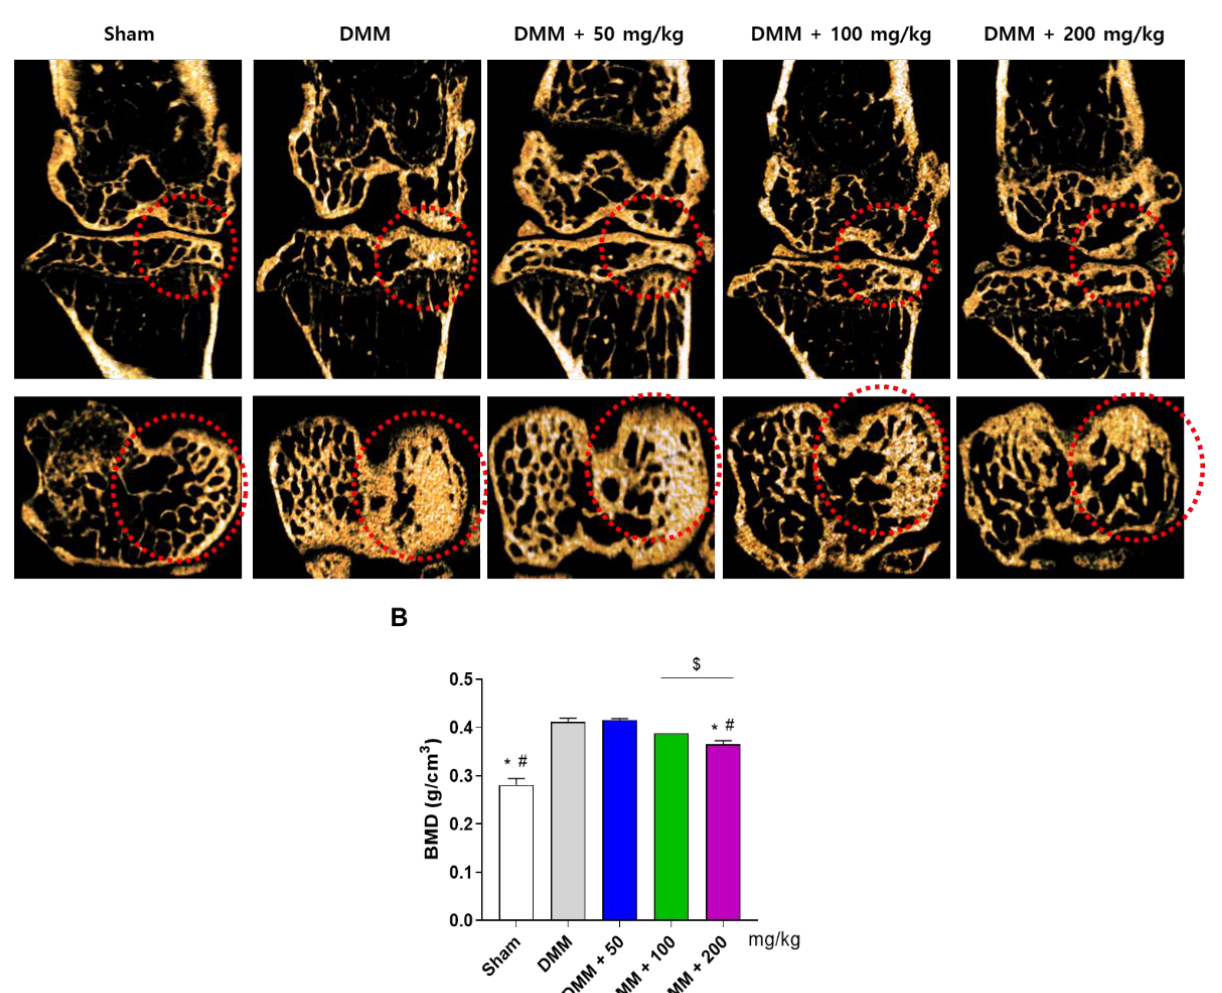
Figure 5. Effects of PG extract on DMM-induced mouse OA model. Mice were induced OA by DMM, and different concentrations of PG extract (50, 100, and 200 mg/kg) were administered for 8 weeks. ( A ) Subchondral knee joint was scanned by micro-CT. ( B ) BMD of the subchondral knee joint was determined. * p < 0.05 vs. DMM, # p < 0.05 vs. DMM + 50, $ p < 0.05 vs. Sham. Sham; non-treated group.